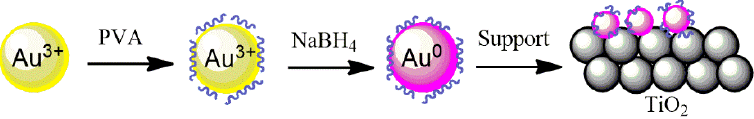
Figure 9. Method of sol-immobilization with PVA for Au/TiO 2 .